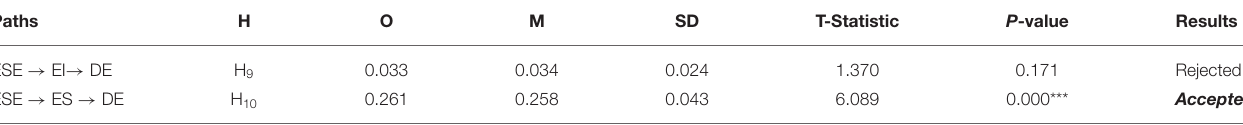
TABLE 6 | The direct effects of the variables. Paths H O M SD ESE → EI →